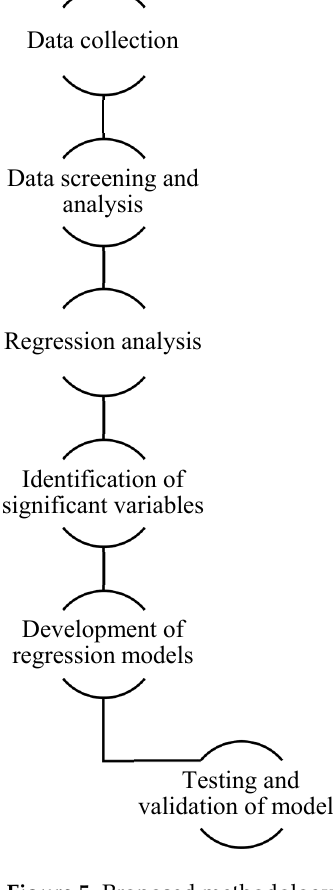
Figure 5. Proposed methodology.